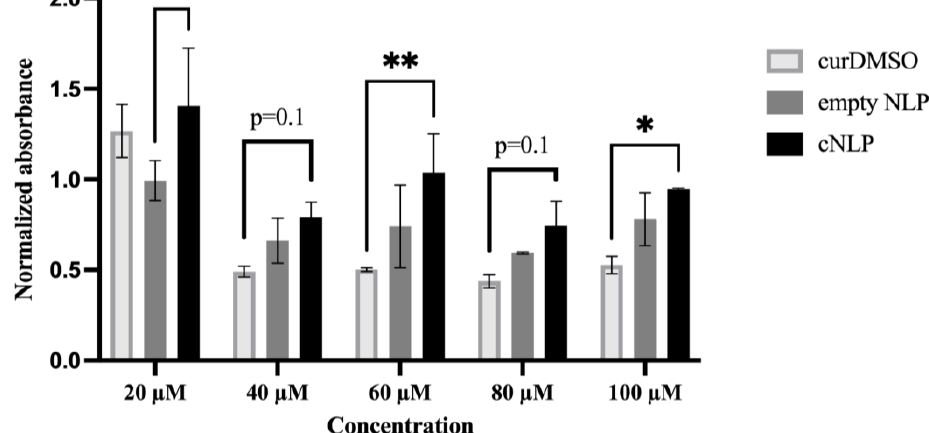
Figure 3. MRC-5 cells tolerate cNLP better than DMSO solubilized curcumin. AG05965/MRC-5 fibroblasts were pre-treated for 18 h with various concentrations of empty NLP (no curcumin) or with curcumin solubilized in nanodiscs (cNLP) or DMSO (curDMSO). MTS reagent was applied to measure cell proliferative capacity. Shown is the mean normalized absorbance ± SD. All wells were normalized to cells treated with media alone. p -values are labeled as <0.05 (*), <0.01 (**), <0.001 (***), and <0.0001 (****).